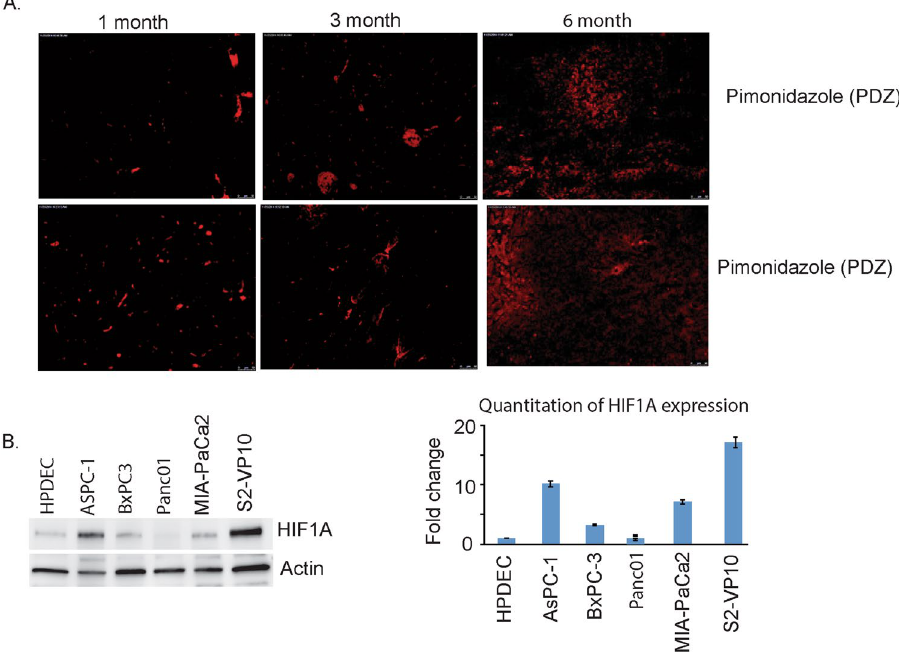
Figure 1. Pancreatic tumors are hypoxic. As the tumor in a KPC mouse progresses, there is increased hypoxic areas as seen by pimonidazole accumulation. Representative tumors from 6 KPC mice at different stages are shown ( A ). The cell lines show an increased expression of HIF1A protein compared to normal pancreatic ductal cells as seen in the western blot and quantitation ( B